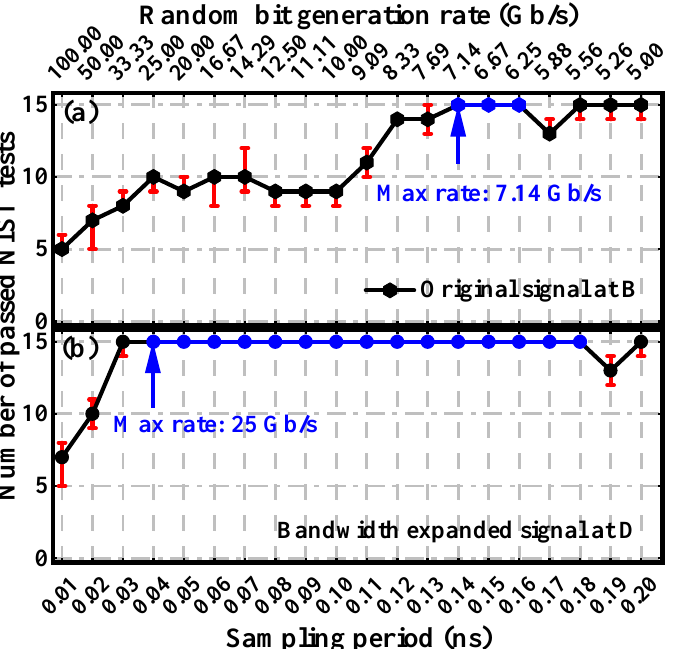
Figure 7. Entropy rate performance for ( a ) the original signal at B and ( b ) the bandwidth expanded signal at